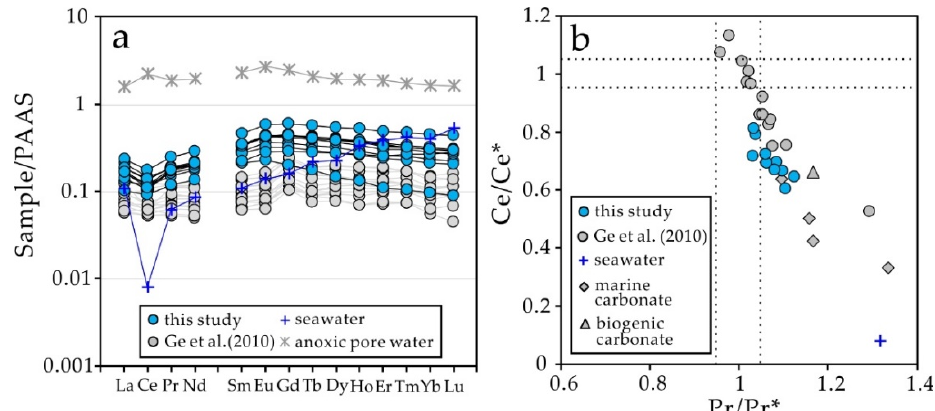
Figure 6. Shale-normalized REE patterns and plot of Pr/Pr* versus Ce/Ce* of tubular carbonates. ( a ) The fragments of tubular carbonate have REE patterns similar to those of the samples of Ge et al. [44] but are different from those of seawater (×10 6 ) and anoxic pore water (×10 6 ) [45–47]. ( b ) Plot of Pr/Pr * versus Ce/Ce * used to reveal Ce anomalies of the studied samples [41]. The fragments of tubular carbonate display negative Ce anomalies, which are similar to those of seawater, biogenic carbonate, and non-seep marine carbonates (data from [46,48]).